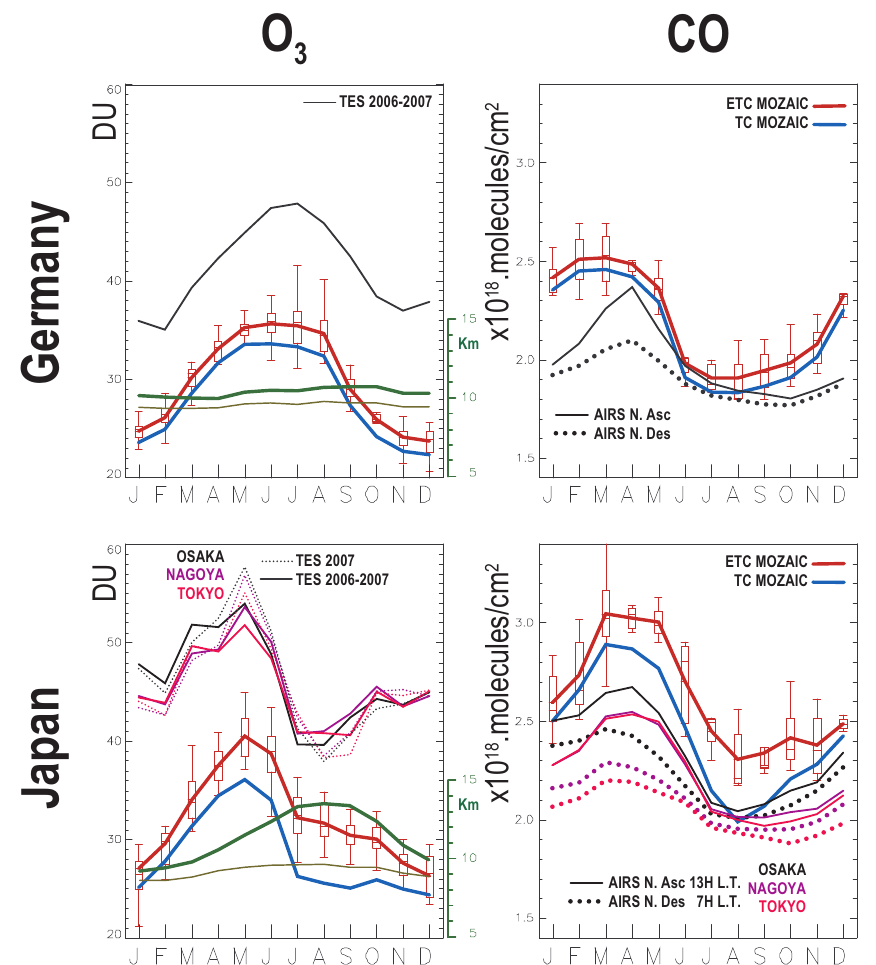
Fig. 13. Seasonal cycles MOZAIC PTC and satellite comparison, i.e. PTC m ( O 3 ) with TES O 3 tropospheric columns (left, in DU) and PTC m ( CO ) with AIRS CO total columns (right, in × 10 18 moleculescm − 2 ) over Germany (top) and Japan (bottom). MOZAIC TC is the blue line and PTC the red line with box-and-whisker plots (as in Fig. 5). The solid green line, z DT , and the dotted green line, as defined in Fig. 4, (in kilometres, right green vertical axis) show the unvisited tropospheric layer, 1 . The satellite results are plotted in black over Germany, and in pink, black and purple over Japan for Tokyo, Osaka and Nagoya, respectively. AIRS CO results are given twice a day for ascending node (13:00LT, solid line) and descending node (07:00LT, dotted line). O 3 tropospheric columns from TES in 10 18 moleculescm − 2 over the periods 2006–2007 or 2007 (solid lines or dotted lines) are converted into DU dividing by 2 . 686 × 10 16